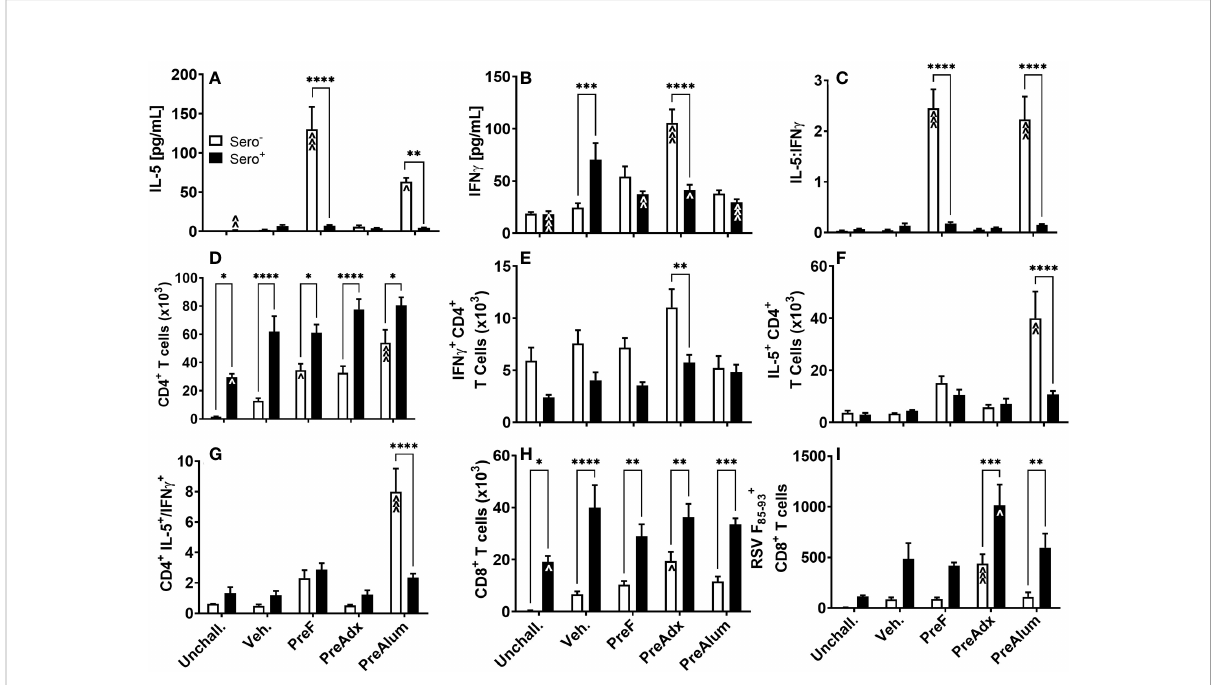
FIGURE 3 Prior RSV exposure mitigates Th1- and 2-type responses linked to vaccination in sero- mice but increases RSV F 85-93 -speci fi c CD8 T cells. Sero- and sero+ mice were immunized and challenged with virus as described in Figure 1. At 4dpi, IL-5 (A) and IFN g (B) were quanti fi ed in the BAL by Luminex and the ratio of IL-5/IFN g (C) was calculated. Total CD4 (D) and CD8 (H) T cells as well as RSV F 85-93 -speci fi c CD8 T cells (I) were measured in the BAL by fl ow cytometry. Intracellular production of IFN g (E) and IL-5 (F) by CD4 T cells was quanti fi ed in BAL and the ratio of IL- 5/IFN g produced by CD4 T cells was calculated (G) . Data are represented as mean ± SEM of two independent experiments ( n = 8 mice). Statistical signi fi cance was determined between sero- and sero+ groups within each immunization cohort using 2-way ANOVA with a Bonferroni post-test; *p<0.05, **p<0.01, ***p<0.001, and ****p<0.0001. Comparisons to Veh controls within the respective sero- and sero+ groups were made using an ANOVA with a Dunnett ’ s multiple comparison test; ^p<0.05, ^^p<0.01, and